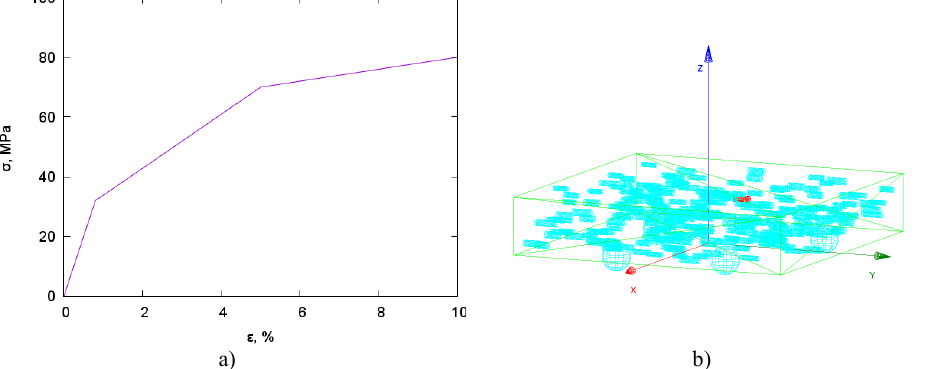
Fig. 2. Stress-strain curve for model carbon (a), and a schematic of cylindrical carbon inclusions